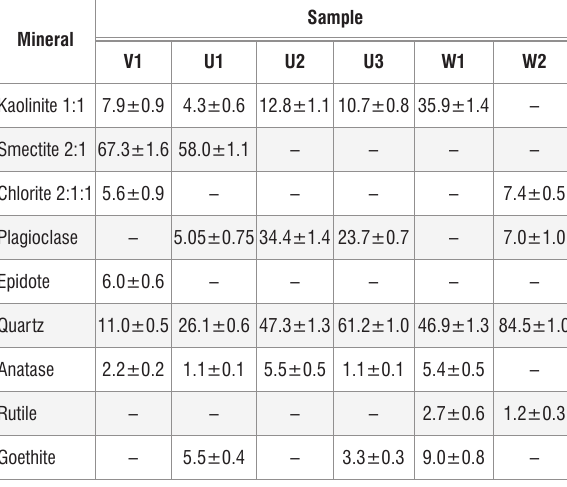
X-ray diffraction derived mineral content (wt%) estimated using Autoquan